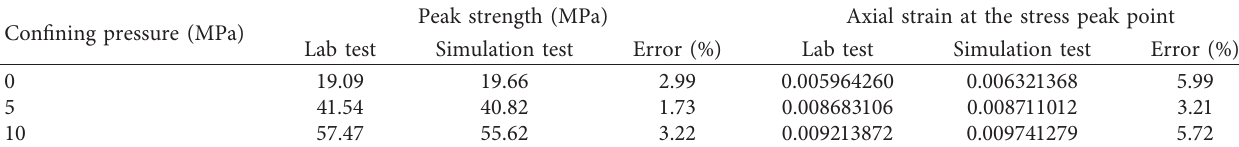
Table 2: Comparison of peak strength and strain at the peak stress point in the simulation test and lab test. Confining pressure (MPa)